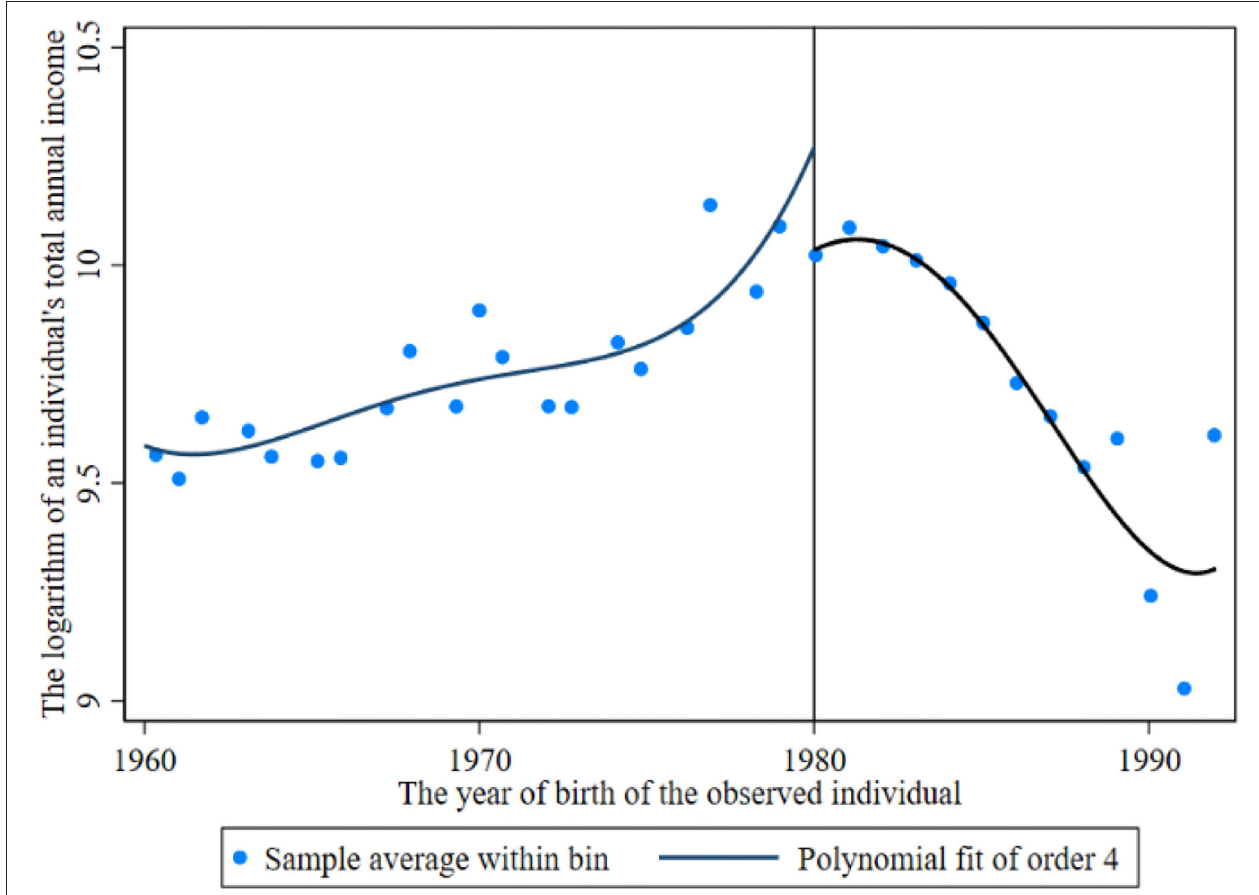
FIGURE 2 | Income breakpoint of urban residents before and after the implementation of the reproductive health